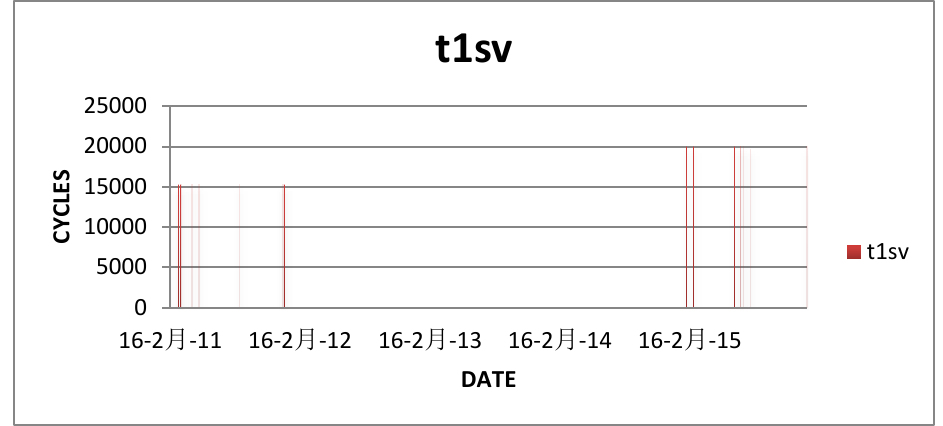
Figure 6. Life-limited parts (LLP) data from the engine removal report relating to the landing.